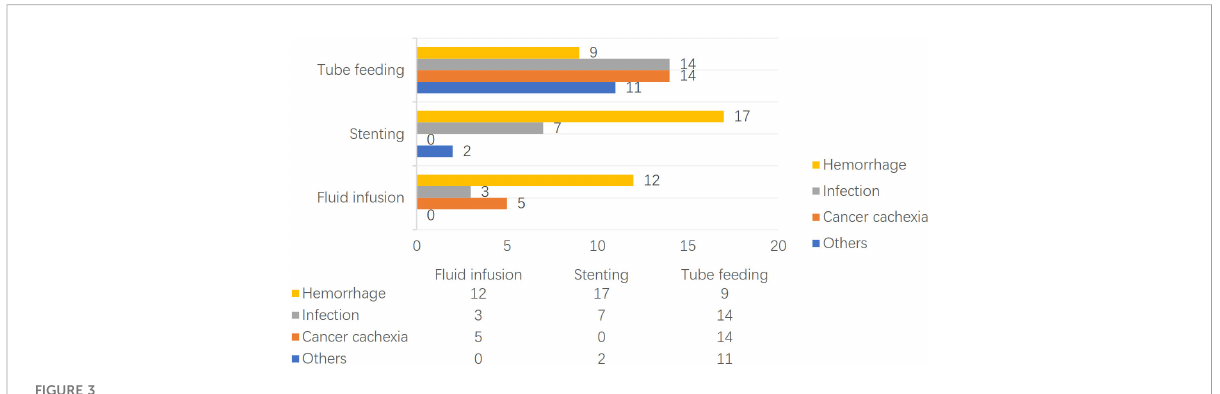
FIGURE 3 The treatment after EP and causes of death.